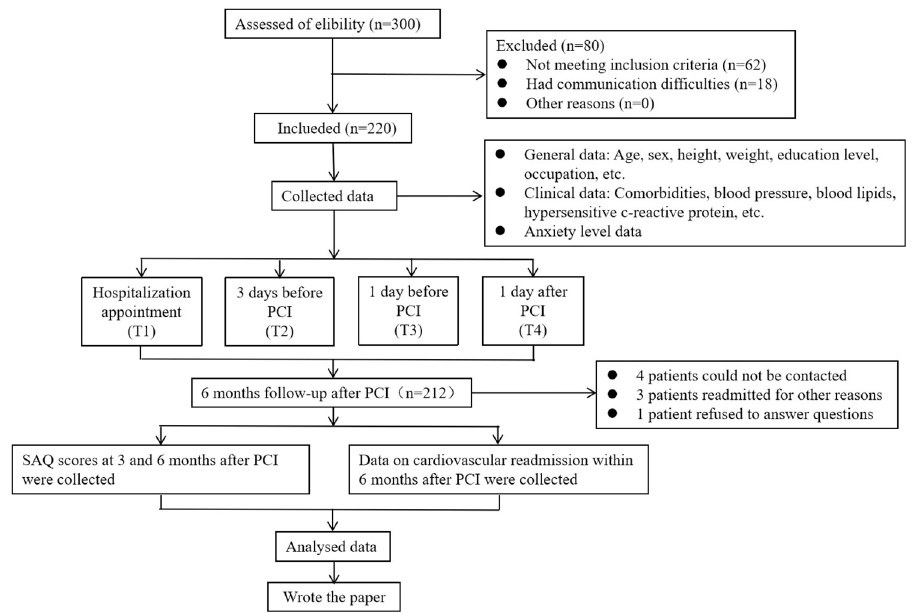
Fig 1. Flow chart of recruitment and follow-up for the entire study. PCI = percutaneous coronary intervention; SAQ = Seattle Angina Questionnaire.